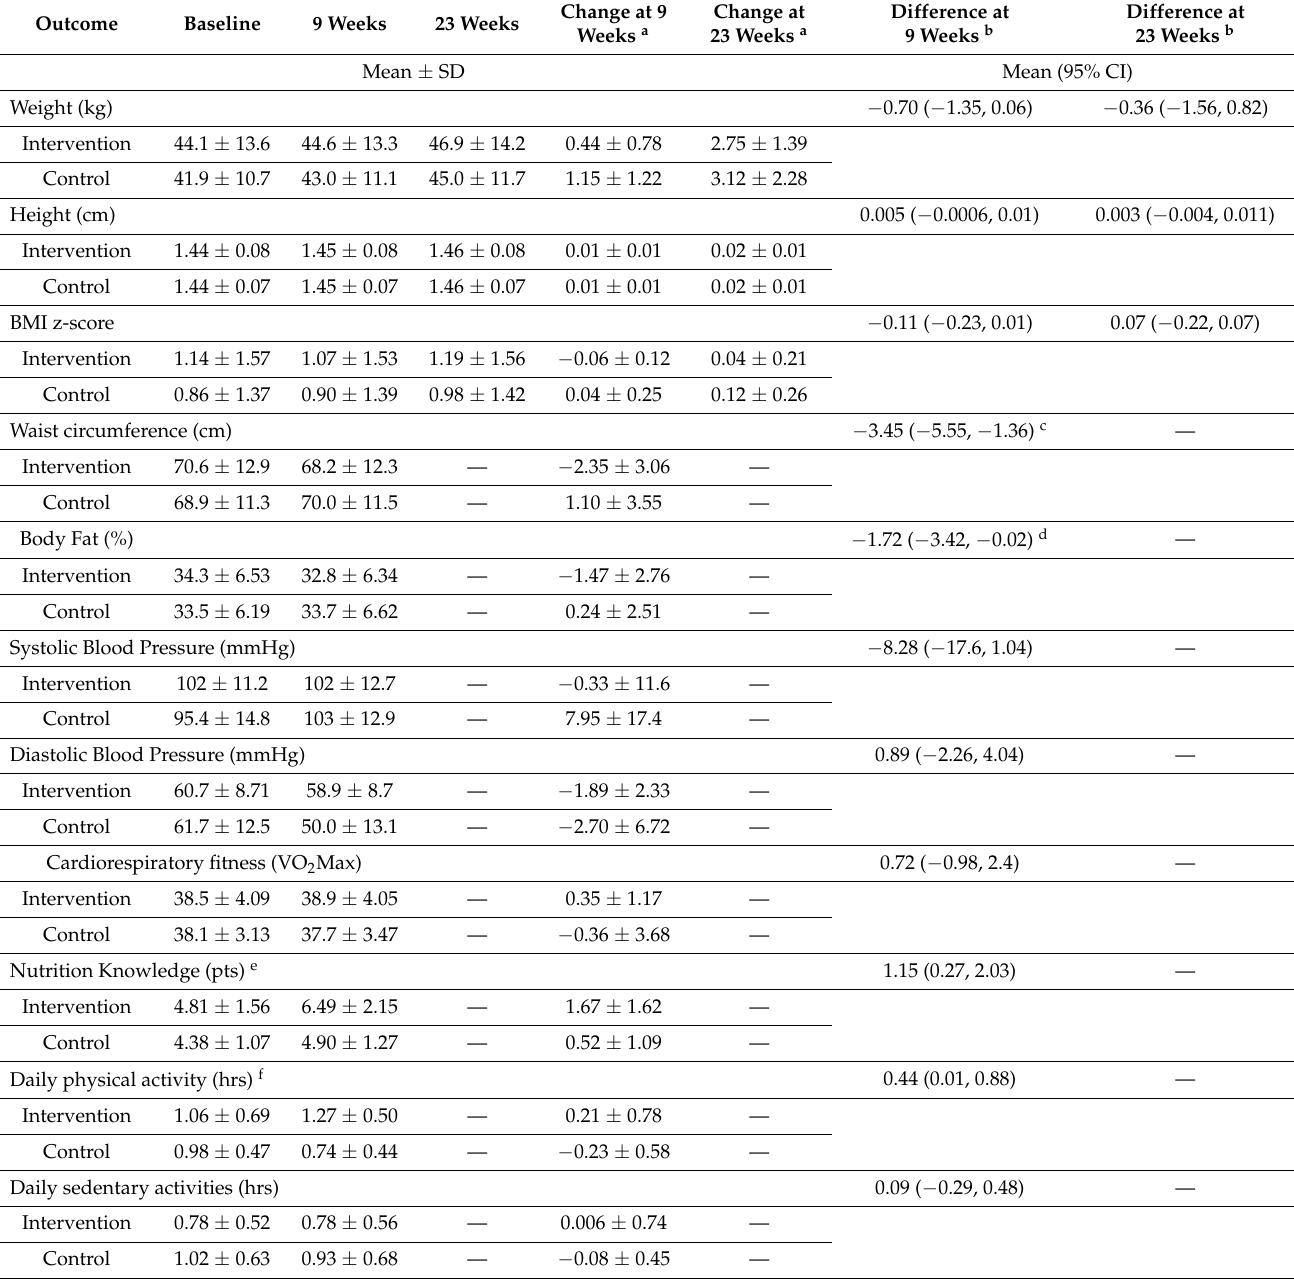
a Obtained with the 9-week value minus the baseline value. b Defined as change for the intervention group minus change for the control group. c p = 0.001. d pts = points, scale (0–10). e p = 0.021. f p =